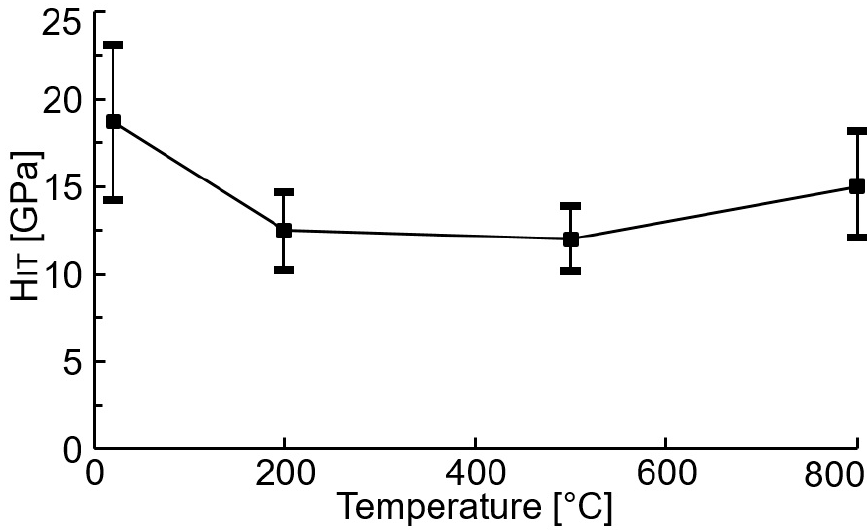
Figure 9. The H IT values vs. the annealing temperature of the tested WC/C coatings.